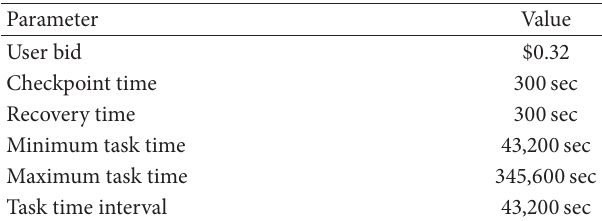
Figure 19: Comparison of rollback times according to the task time. Table 3: Simulation parameters and values.